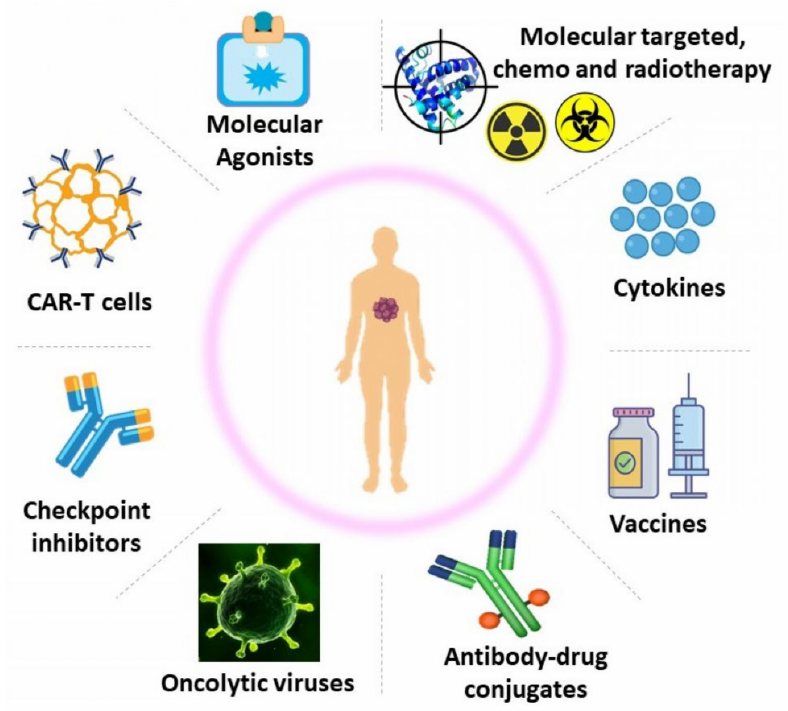
Figure 1. Cancer immunotherapy.